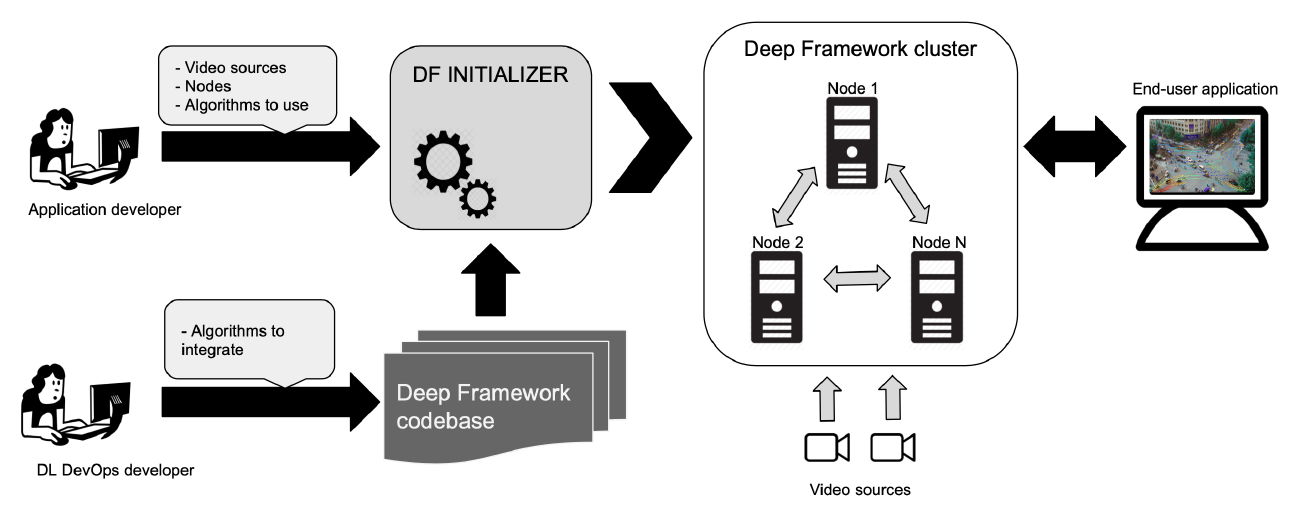
Figure 1. Overview of Deep-Framework workflow. The framework provides tools for the integration of new algorithms and for defining and launching a complete video analytics application on a computational cluster based on available